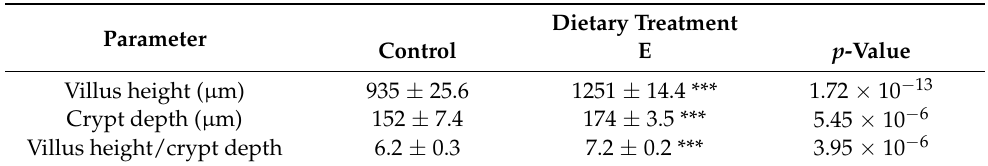
Table 5. Measurements of the jejunal villus height and crypt depth for the control and experimen- tal groups.